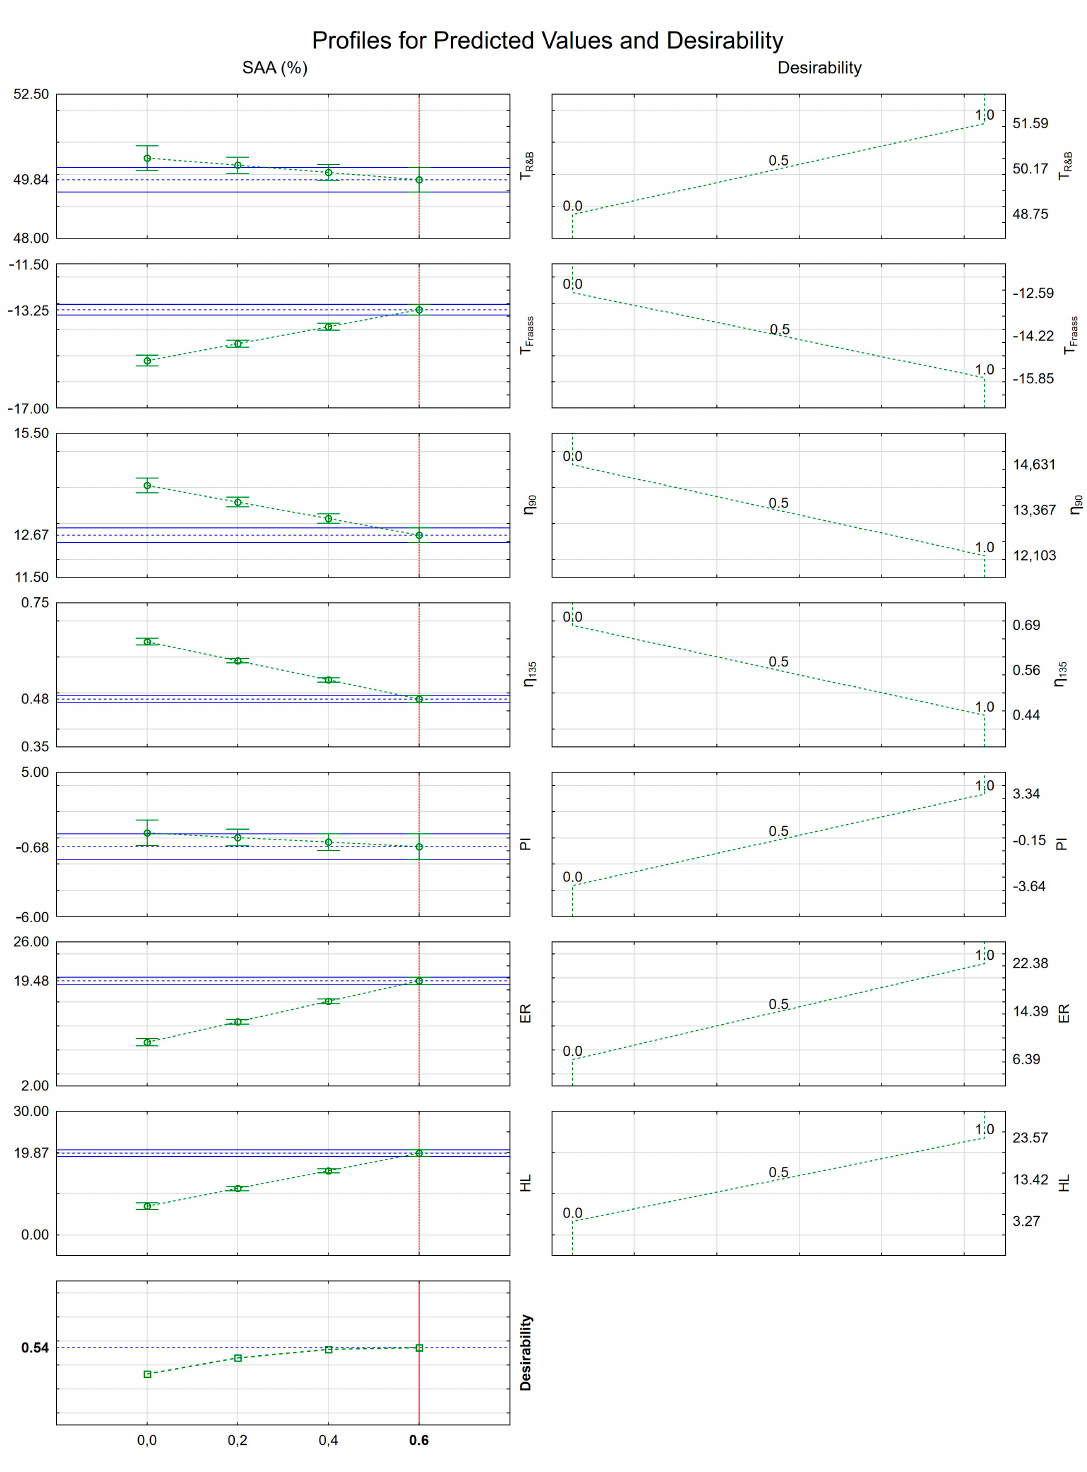
Figure 9. Determination of the best performing content of SAA for the best possible properties of 50/70 binder.